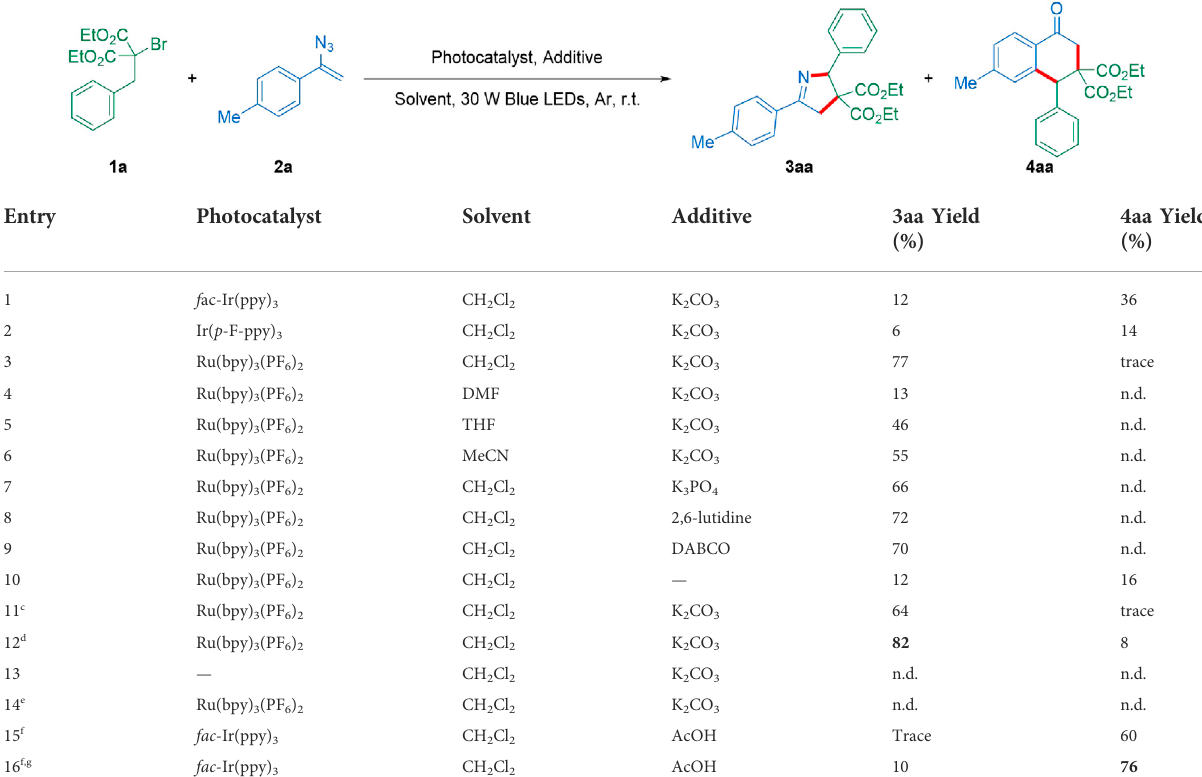
TABLE 1 Optimization of the reaction conditions a,b .